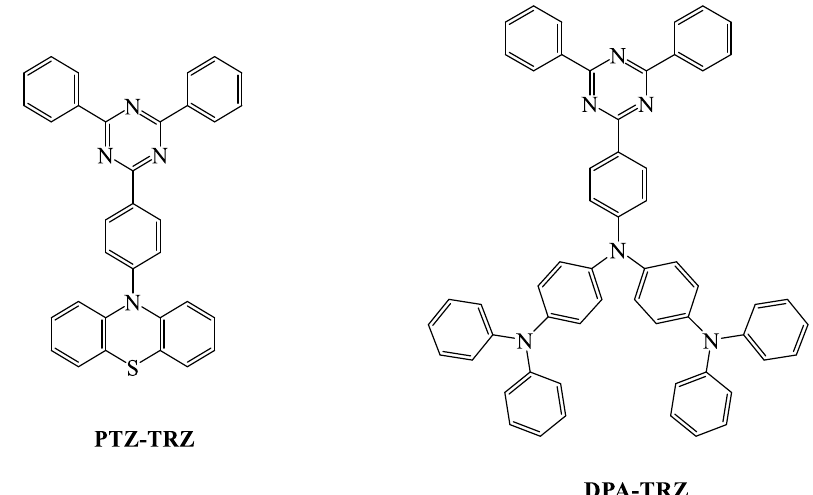
Figure 5. Molecular structures of triazine acceptors with phenothiazine and diphenylamine donor moieties.